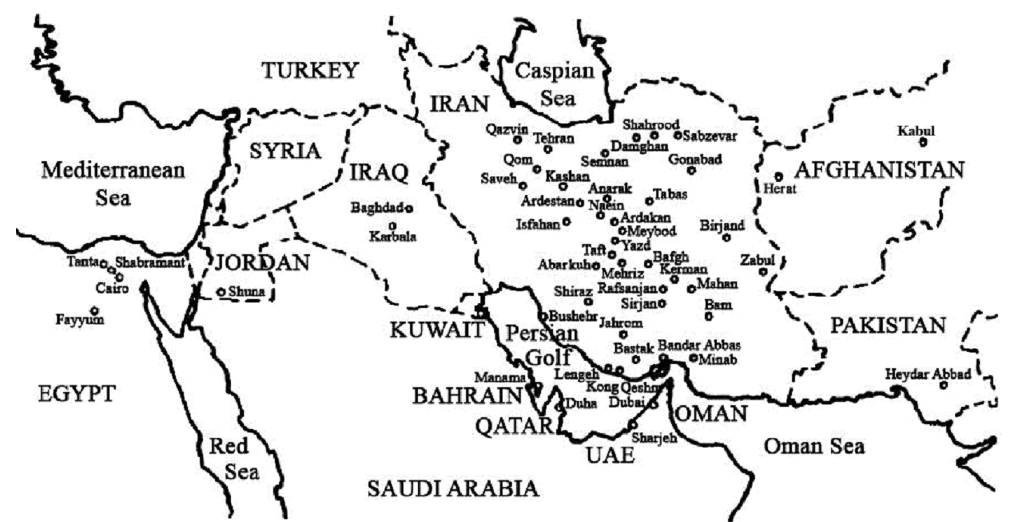
Figure 1. The areas in the Middle East that have employed the conventional and traditional wind towers